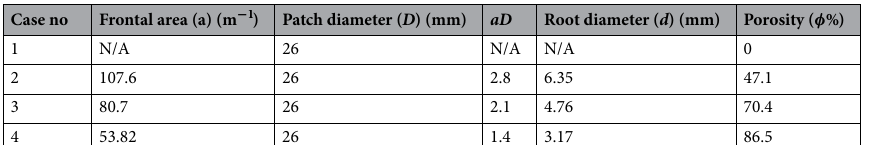
◦ mirror was used to have